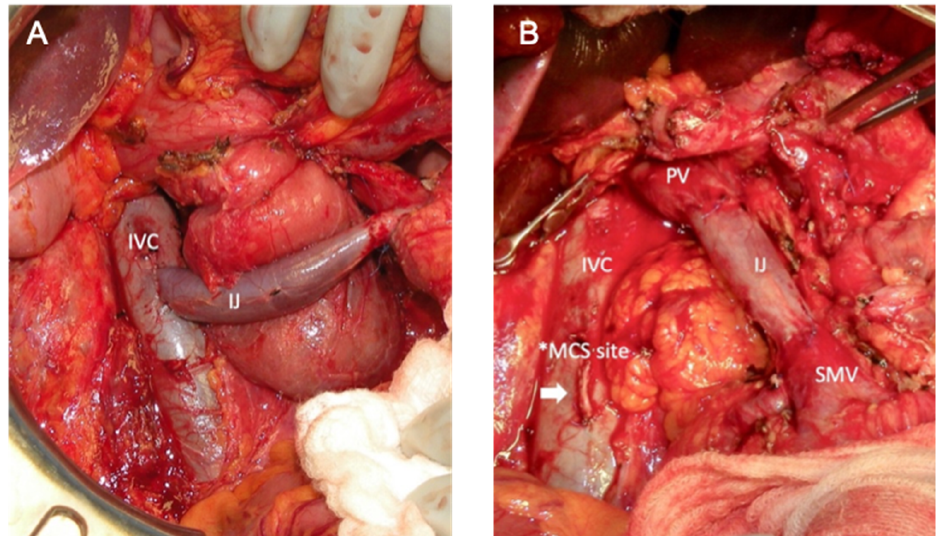
Figure 3. Intraoperative photos of the creation of a mesocaval shunt (MCS) via use of the removed internal jugular vein (IJ). The shunt is between the inferior vena cava (IVC) and superior mesenteric vein (SMV) ( A ) to facilitate dissection of the tumor, and the completed vein reconstruction is shown in ( B ) from the portal vein (PV) to the SMV, with the old MCS site to the IVC shown as a staple line to be able to swing the IJ vein towards the SMV for the distal anastomosis.